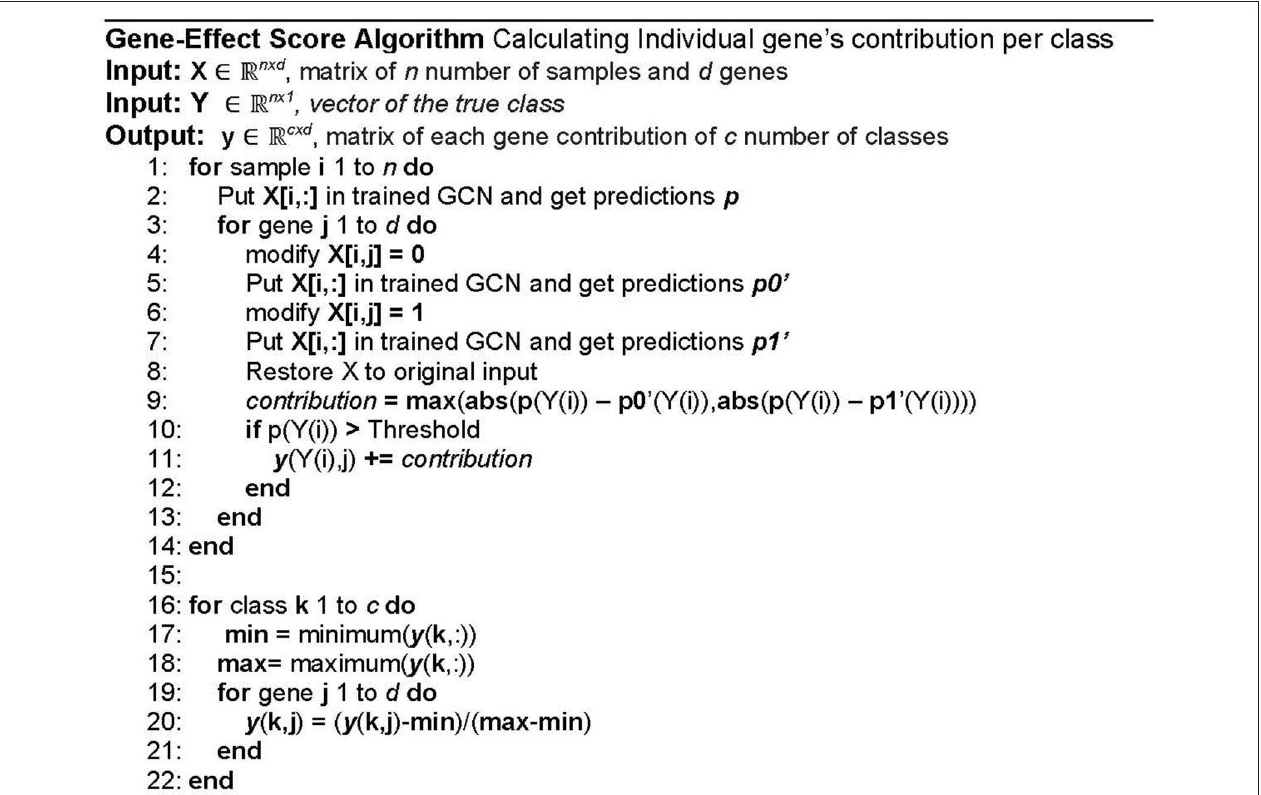
FIGURE 3 | The pseudocode for the in silico gene perturbation post-modeling analysis.